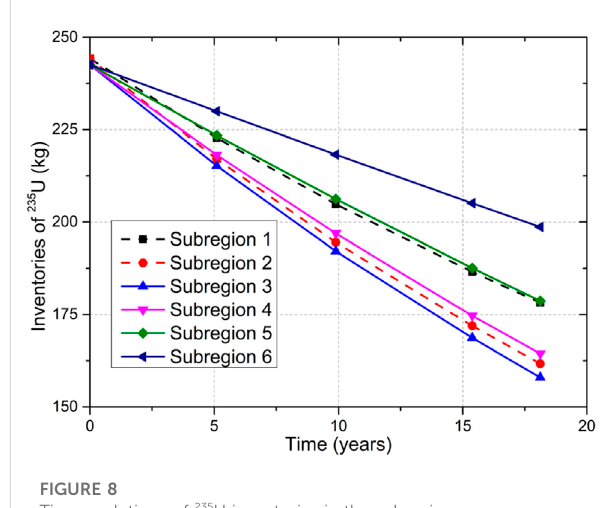
FIGURE 8 Time evolutions of 235 U inventories in the subregions.